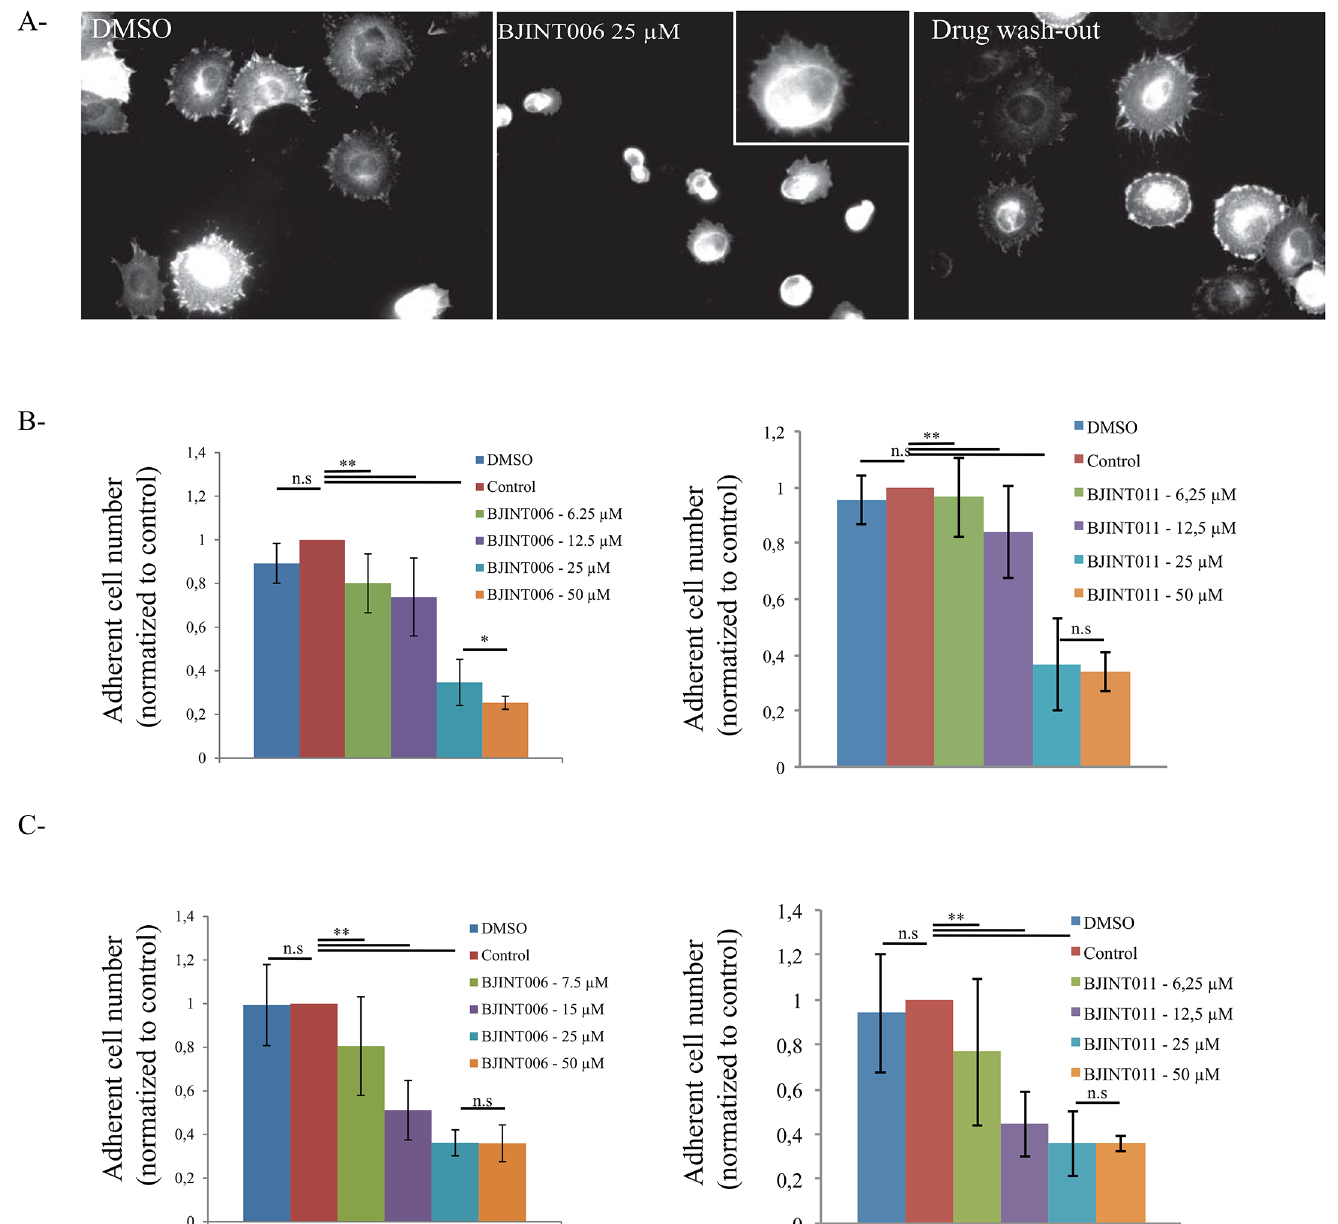
Fig 1. BJINT derivatives promote focal adhesion disassembly and cell detachment in a reversible and dose dependent manner. (A) Suppression of cell spreading under BJINT006 treatment. Pre-osteoblasts expressing GFPkindlin-2 were spread on fibronectin coated coverslips (5 μ g/mL) for 1 h 30 at 37°C before adding the BJINT drugs and incubation was continued for 1 h. (left and central panels) Reversibility of BJINT006 after 1 hour drug wash-out (right panel). (B) Cells were treated with increasing BJINT006 and 011 concentrations and adhesion was compared to untreated cells (control) or cells treated with vehicle (DMSO). Cells were spread for 1h30, and then treated for 1h. After fixation, they were stained with Crystal Violet (0.5% w:v) and optical density was read at 620 nm. (C) Cells in suspension were treated for 1h at 37°C then let to attach and spread on fibronectin coated dishes for 1 h 30. They were compared to cells treated with vehicle (DMSO) or untreated (control). Adherent cell numbers were estimated as described